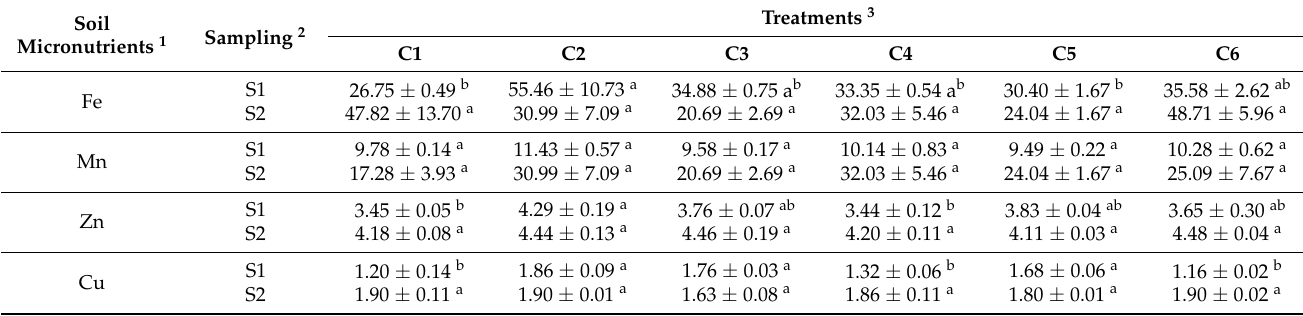
Table 2. The effects of fertilizer and microbial inoculants on soil concentration of micro-elements.